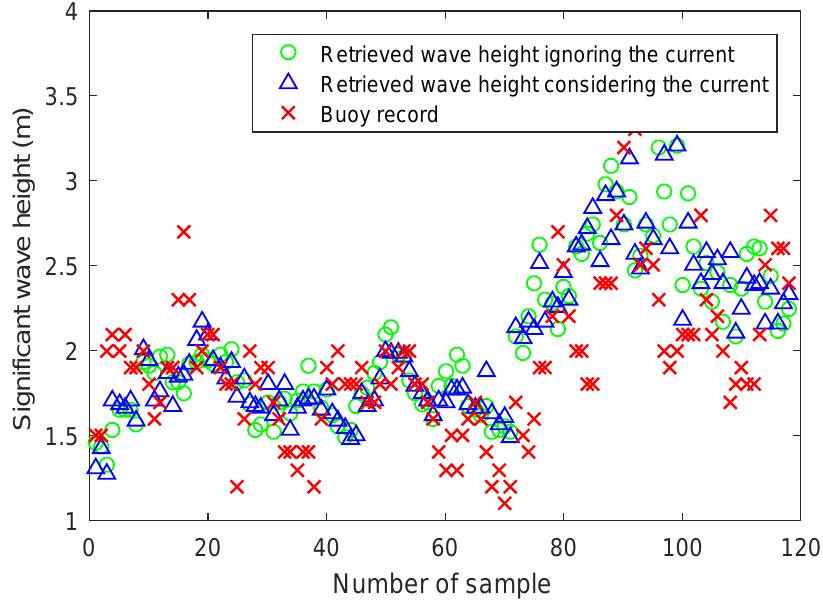
Figure 6. The sequence of the significant wave